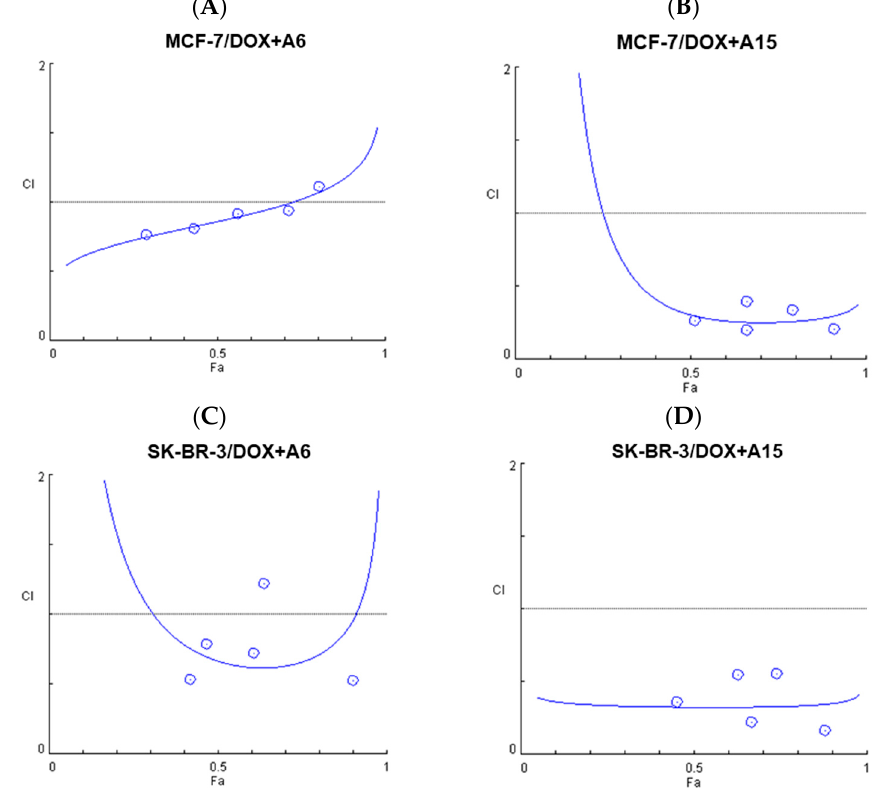
Figure 11. Fractional effect ( F a ) and combination index (CI) plots obtained from CompuSyn Report for the combinations of doxorubicin (DOX) with A6 or A15 on MCF-7 and SK-BR-3 cells. ( A , B ) DOX and ( A ) A6 or ( B ) A15 on MCF-7 cells; ( C , D ) DOX and ( C ) A6 or ( D ) A15 on SK-BR-3 cells. CI is plotted on the Y-axis as a function of the effect level ( F a ) on the X-axis to validate synergism of the combination pairs.